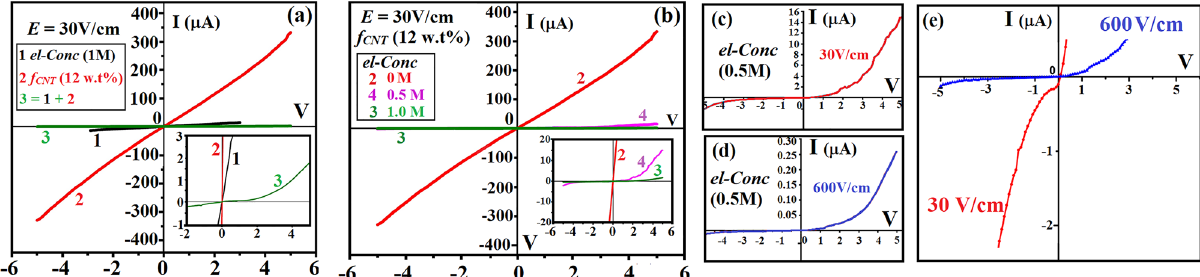
Figure 5. The I–V profiles of samples 1 , 2 and 3 at ± 6 V and highlighted profile at ± 4 V ( a ). The I–V profiles of samples 2 , 3 and 4 at ± 6 V and highlighted profile at ± 4 V ( b ). Highlighted I–V profiles of sample 4 made at E = 30 V/cm ( c ) and 600 V/cm ( d ). Highlighted I–V profiles of ( c ) and ( d ) at ± 5 V and I = ± 2 μA ( e ).